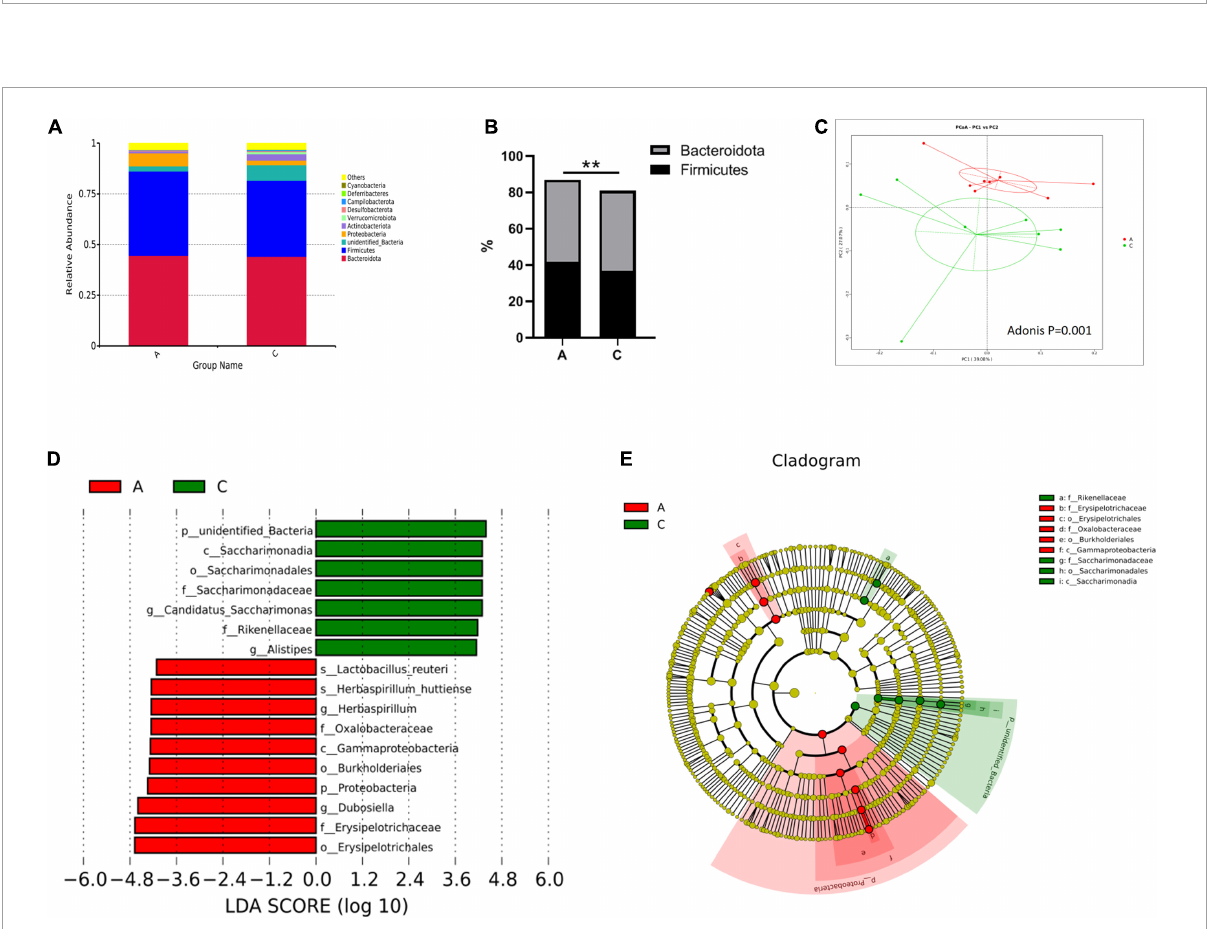
FIGURE3 Gut microbiota composition in APP/PS1 and wild-type mice. Relative abundance stacked barplots at the phylum level (A) and the Firmicutes/Bacteroidota ratios (B) . PCoA based on the weighted UniFrac phylogenetic distance is compared between APP/PS1 and wild-type mice (adonis P < 0.01) (C) . Comparison of the representative taxonomic abundance between the two groups identified by LEfSe (D) . Cladogram of the taxa enriched in the gut microbiota (E) . The central point represents the root of the tree (bacteria), and the ring represents the taxonomic level (phylum to genus). The diameter of the ring represents the relative abundance of that taxon. Groups: A, APP/PS1 double-transgenic mice; C, wild-type control group of C57BL/6J mice; n = 8/group. ** P <